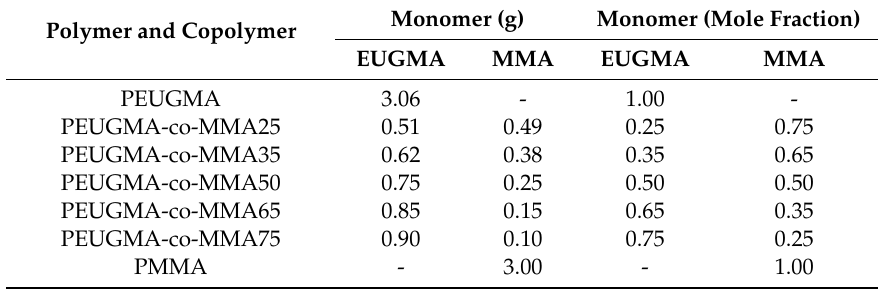
Table 1. Preparation conditions of PEUGMA, PMMA and PEUGMA-co-MMA. Polymer and